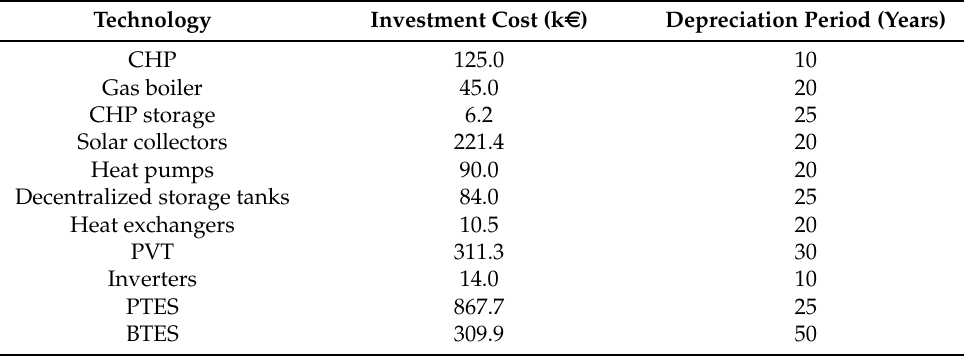
Table 3. Investment cost and depreciation period for different heating